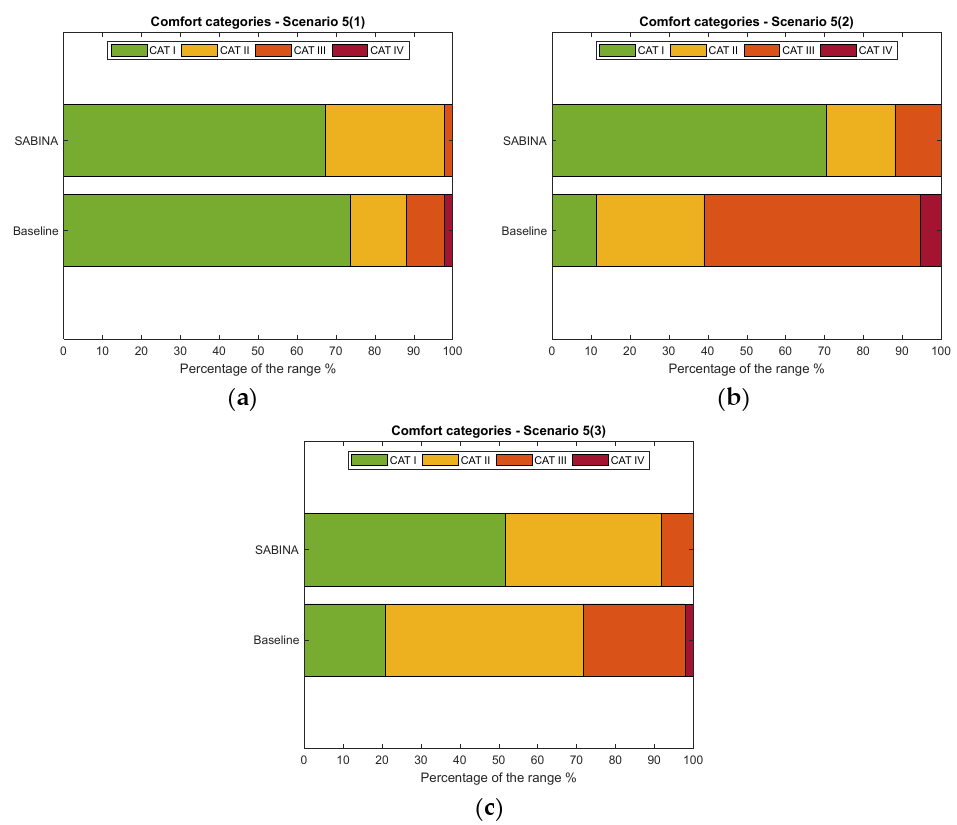
Figure 10. Comfort level: ( a ) Period 1; ( b ) Period 2; ( c ) Period 3.